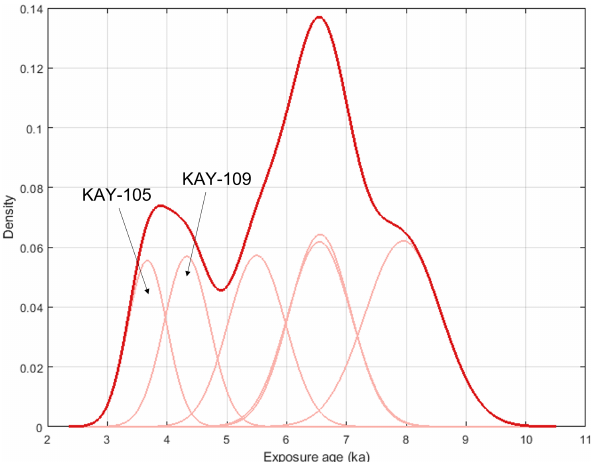
Figure A1. Kernel density estimate plot of in situ 14 C age ( n = 6) distribution for lower Kay Peak ridge. Error weighted mean: 5173; reduced chi squared: 15.37; chi-squared p value: 0.0000.